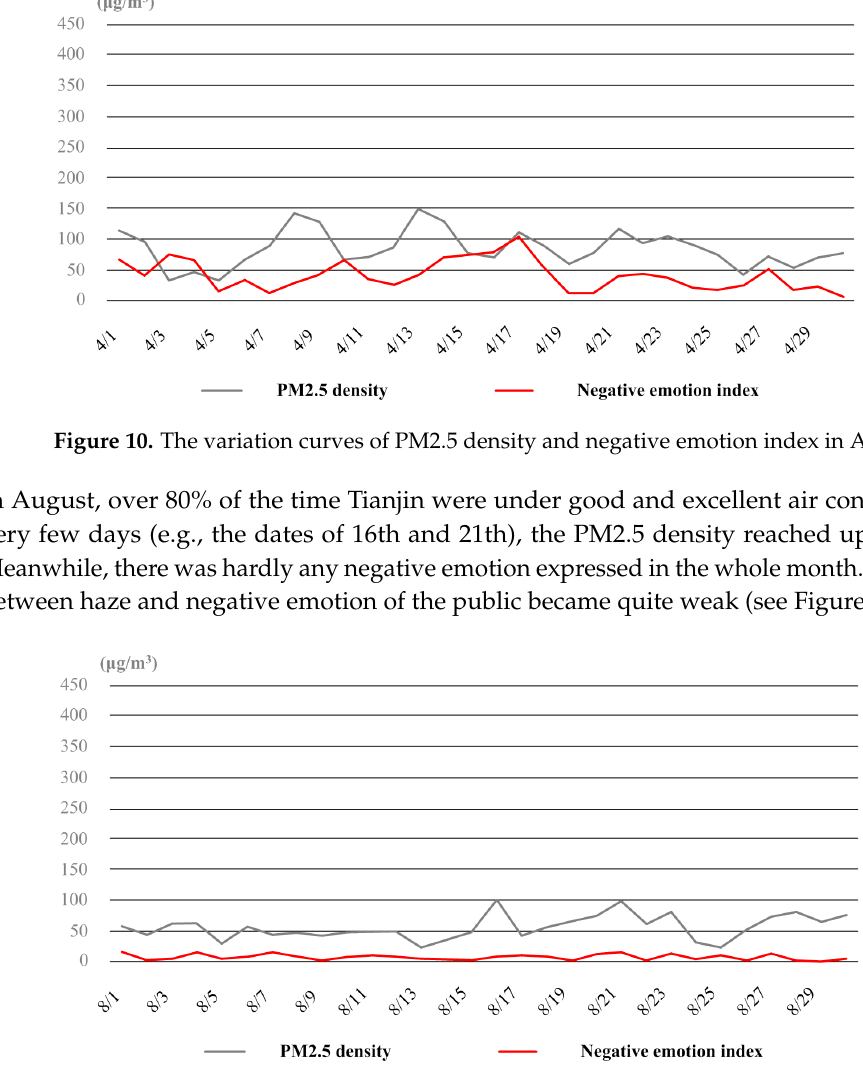
Figure 11. The variation curves of PM2.5 density and negative emotion index in August.